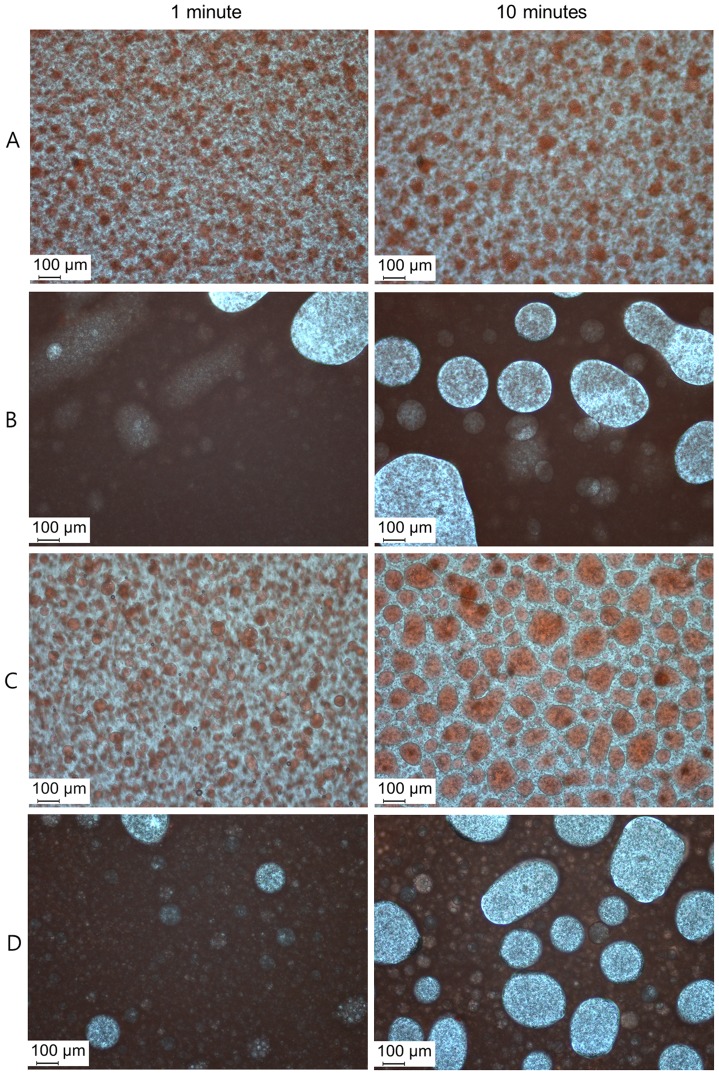
Photograph of four types of Lipiodol emulsions: (A) 10 mg of DOX in 0.5 ml of Pamiray mixed with 2 ml of Lipiodol, (B) 10 mg of DOX in 1.25 ml of Pamiray mixed with 1.25 ml of Lipiodol, (C) 10 mg of DOX in 0.5 ml of NS mixed with 2 ml of Lipiodol, (D) 10 mg of DOX in 1.25 ml of NS mixed with 1.25 ml of Lipiodol.Left images were obtained 1 minute after pumping and right images were obtained 10 minutes after pumping. Most stable w/o emulsion was prepared by 4∶1 volume ratio of Lipiodol and DOX solution in Pamiray (A).